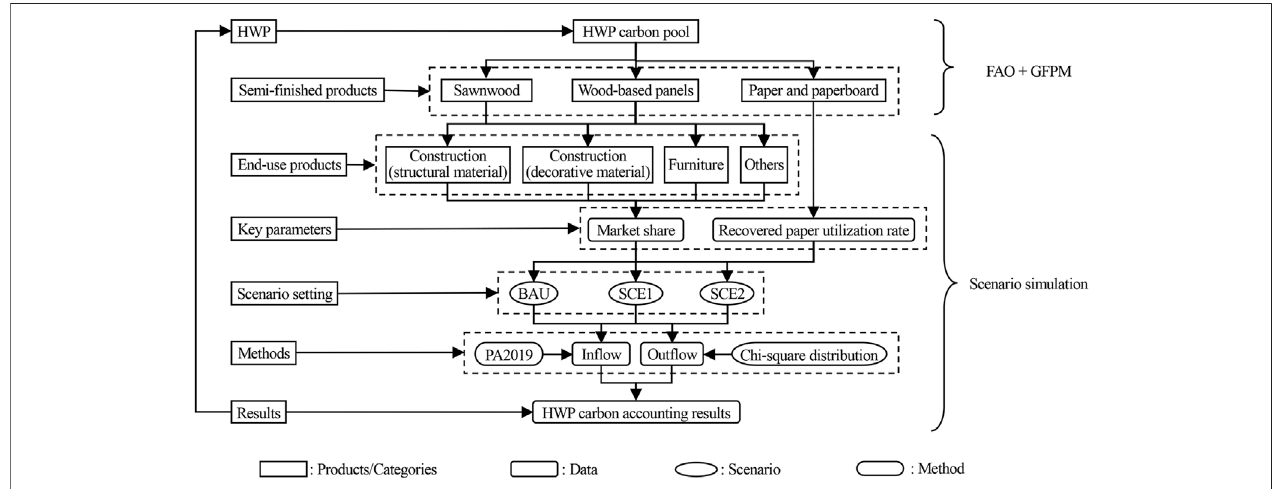
FIGURE 1 | Flowchart of research methods. BAU, SCE1, and SCE2 represent business as usual, scenario 1, and scenario 2, respectively.